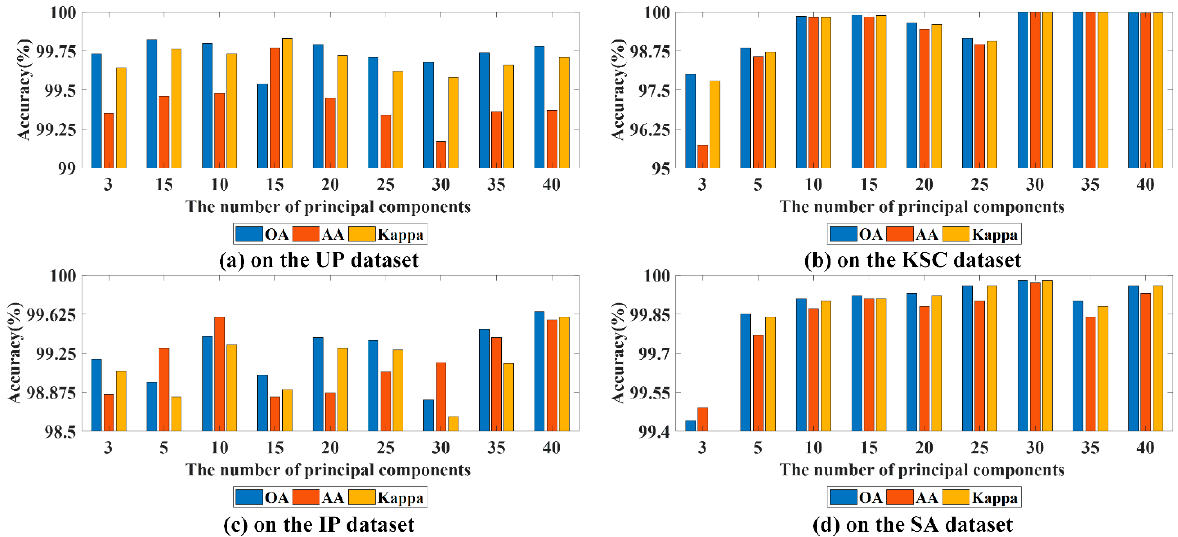
Figure 7. Three evaluation indexes for different numbers of PC on four experimental datasets.